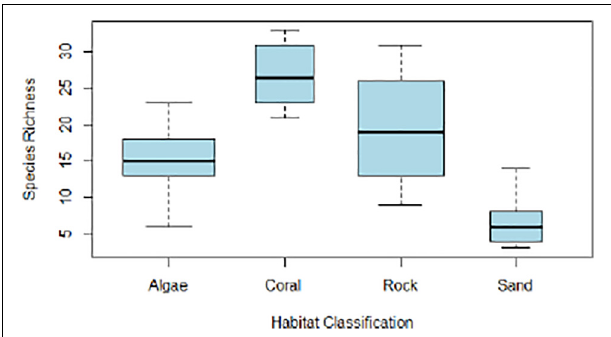
FIGURE 6 | Range of species richness values recorded by BRUVS within each habitat classification.